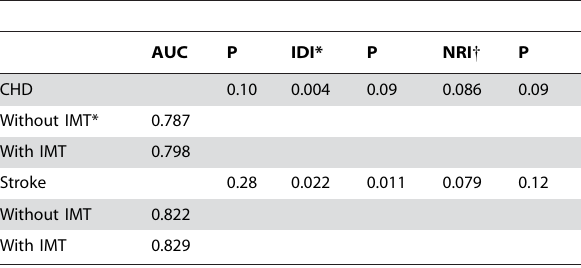
Table 5. Summary statistics comparing risk prediction for the models without and with IMT for the risk of CHD and stroke.